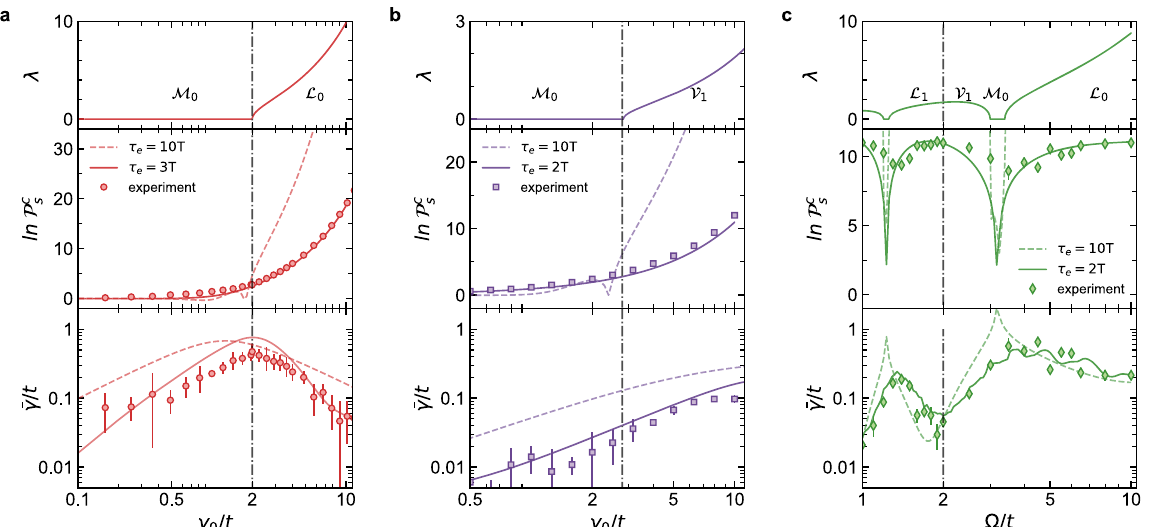
Fig. 3 Observation of the correspondence between quantum (anti-)Zeno effects and the PT phases. Here by varying the kick parameters, the PT phases and (anti-)Zeno effects are respectively indicated by numerically calculated dimensionless parameter λ (upper panel), measured (middle panel), and the measured effective loss rate γ (lower panel). a Dependence of λ , P c and γ on the kick intensity corrected Probability P c s s Ω / t = 10. The exceptional point is at γ = 2 (dash-dotted line). b Dependence of λ , P c γ and γ on during the 0 under a large kick frequency 0 / t s duty time under a small kick frequency Ω / t = 2.5. The exceptional point is at γ 0 / t = 2.8 (dash-dotted line). c Dependence of λ , P c and γ on the s kick frequency Ω with a fi xed γ 0 / t ∼ 9 . The evolution τ e = 3 T for panel ( a ), while τ e = 2 T for panels ( b ) and ( c ). For all experiments, we take t = 2 π × 1.03(2) kHz, and the duty time is τ 0 t /(2 π ) = 0.1. In panels ( a ) and ( b ), we vary γ 0 by choosing different values of t 0 . The solid (dashed) lines in the middle panels are numerical simulations with the experimentally applied τ e (a longer τ e = 10 T ), while the dashed (solid) lines in the lower panels are numerical simulations with Hamiltonian (1) (an effective Hamiltonian including higher-order, non-resonant coupling terms; see Methods). The vertical dash-dotted line in panel ( c ) indicates the critical kick frequency Ω 1 = 2 t . All error bars here indicate one standard deviation from multiple